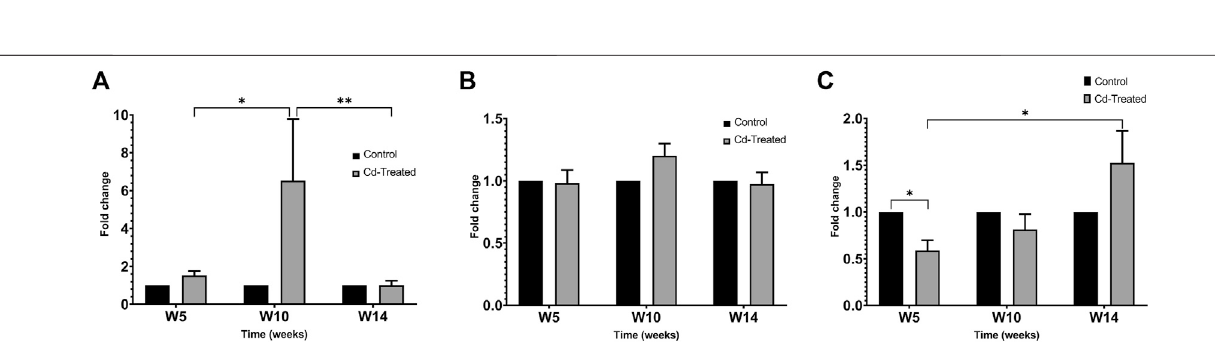
FIGURE 5 | Representative image showing gelatinolytic activity of MMP after 60+ h incubation. Labels show the activity of pro-MMP-9 at 95 kDa, pro-MMP-2 at 72 kDa and active MMP-2 at approximately 65 kDa. The activity of active MMP-9 (82 kDa) was not visible after 60+ h.